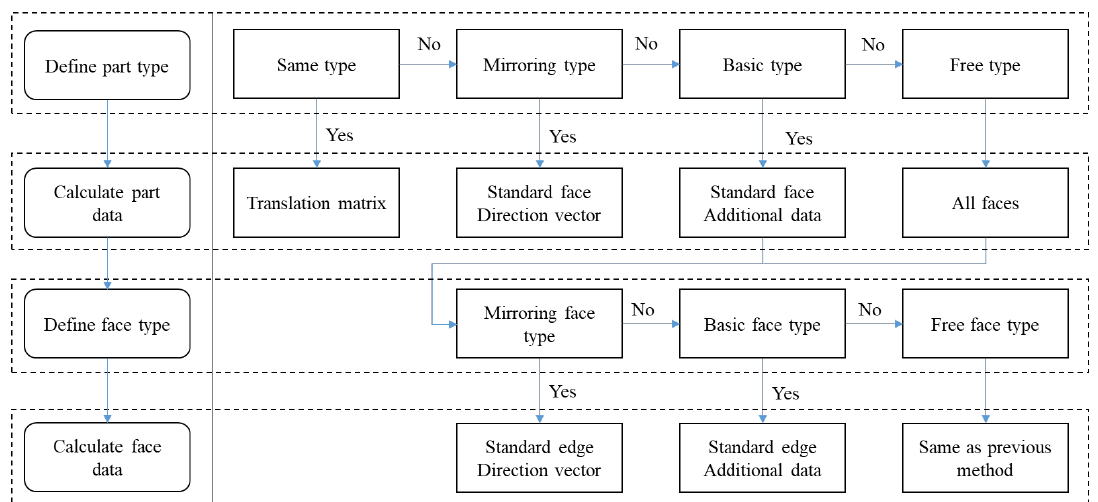
Figure 5. Overall data size minimization process of lightweight 3D models for ships and offshore plants.